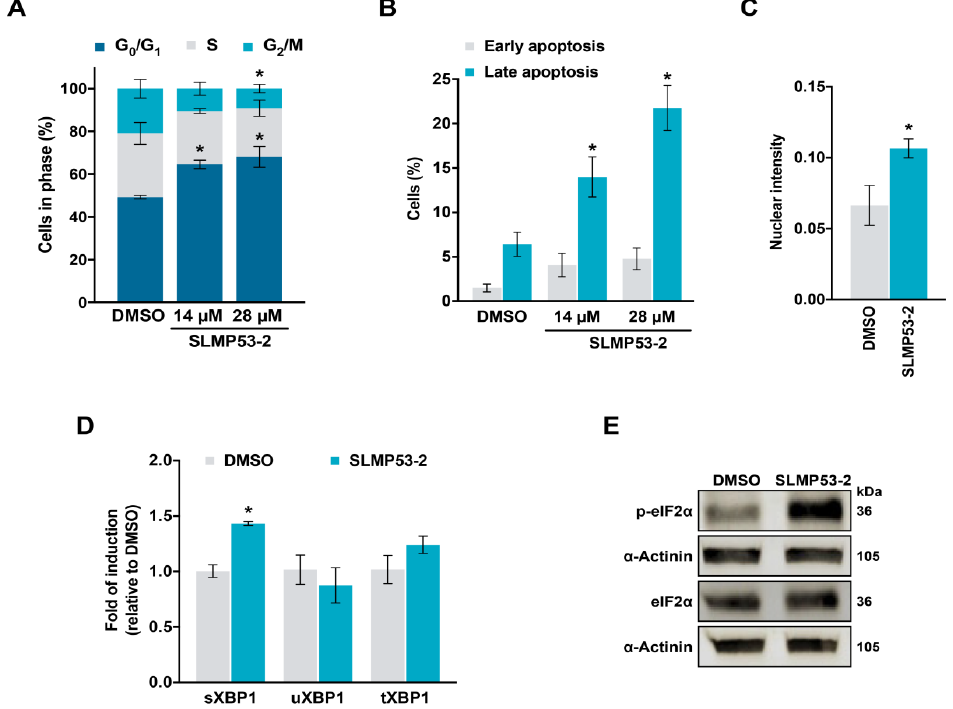
Figure 3. Growth inhibitory effect of SLMP53-2 in hepatocellular carcinoma (HCC) cells is associated with cell cycle arrest, apoptosis, and ER stress. ( A ) Effect of SLMP53-2 on cell cycle progression of HuH-7 cells after 48 h treatment; values significantly different from DMSO: * p < 0.05, two-way ANOVA with Dunnett’s multiple comparison test. ( B ) Effect of SLMP53-2 on apoptosis of HuH-7 cells, after 72 h treatment. Data are mean ± SEM ( n = 5); values significantly different from DMSO: * p < 0.05, one-way ANOVA with Dunnett’s multiple comparison test. ( C ) Quantification of nuclear fluorescence intensity of XBP1 in HuH-7 cells after 24 h treatment with 28 µM SLMP53-2. Data are mean ± SEM ( n = 3); values significantly different from DMSO: * p < 0.05, unpaired Student’s t -test. ( D ) mRNA levels of spliced (sXBP1), unspliced (uXBP1), and total XBP1 (tXBP1) in HuH-7 cells after 24 h treatment with 28 µM SLMP53-2, determined by RT-qPCR; fold of induction is relative to DMSO. Data are mean ± SEM ( n = 3); values significantly different from DMSO: * p < 0.05, two-way ANOVA with Dunnett’s multiple comparison test. ( E ) Protein levels of phosphorylated and total eIF2 α in